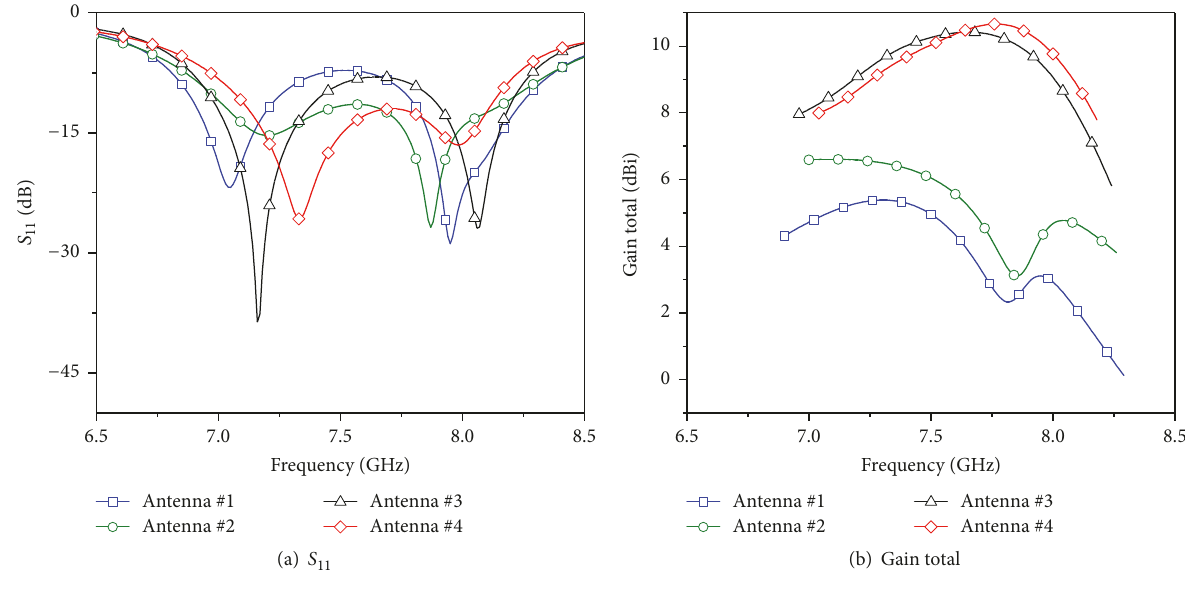
Figure 12: Performance comparison of all